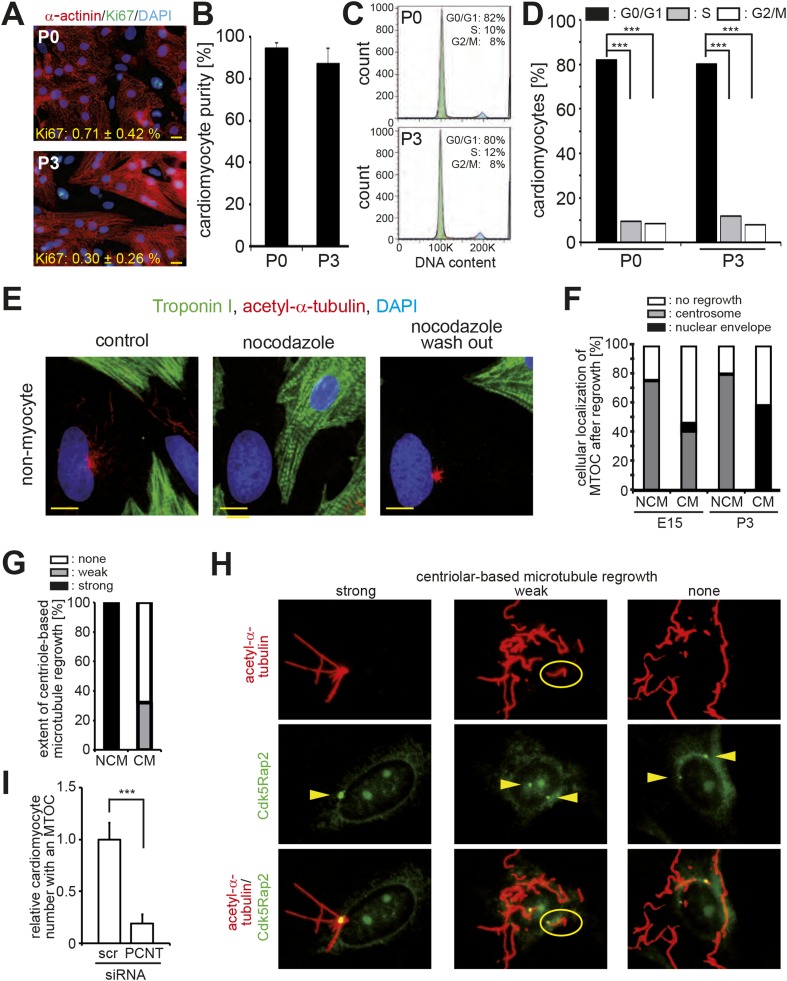
Loss of centrosome function during heart development.(A) Representative images of postnatal cardiomyocytes stained for cell cycle activity (Ki67) and cardiomyocytes (α-actinin) including a quantitative analysis for Ki67-positive cardiomyocytes. Data are mean ± SD, n = 3. ≥ 200 cells were analyzed per experimental condition. Nuclei: DAPI. Scale bars: 20 µm. (B) Quantitative analysis of the purity of cardiomyocyte cultures based on α-actinin. Data are mean ± SD, n = 3. ≥ 150 cells were analyzed per experimental condition. (C) Cell cycle analysis of cardiomyocytes based on DNA content by FACS analysis. Peaks: G0/G1 (green), S-phase (yellow), G2/M (blue). (D) Quantitative analysis of (C). Data are mean ± SD, n = 3. Per experimental condition 10,000 cells were analyzed. (E) Localization of microtubule regrowth in non-myocytes of P3-isolated cardiomyocyte cultures treated with nocodazole or nocodazole followed by wash-out. Scale bars: 10 µm. (F) Frequency of MTOC localization in cardiomyocytes (CM) and non-myocytes (NCM) from different developmental stages after nocodazole wash out. n = 3, ≥ 50 cells were analyzed per experimental condition. (G) Frequency and extent of centriole-based microtubule formation in P3-isolated CM and NCM after nocodazole wash out. > 50 cells were analyzed per condition. (H) Representative images of centriole-based microtubule formation as quantitated in (G). Microtubules (acetylated-α-tubulin), Centrioles (Cdk5Rap2). Arrowheads indicate centrioles. (I) Relative frequency of cardiomyocytes with nuclear envelope-based MTOC after Pcnt siRNA-mediated knockdown. Scr: Scramble siRNA. ***: p < 0.005. n = 3, ≥ 100 cells were analyzed per experimental condition.